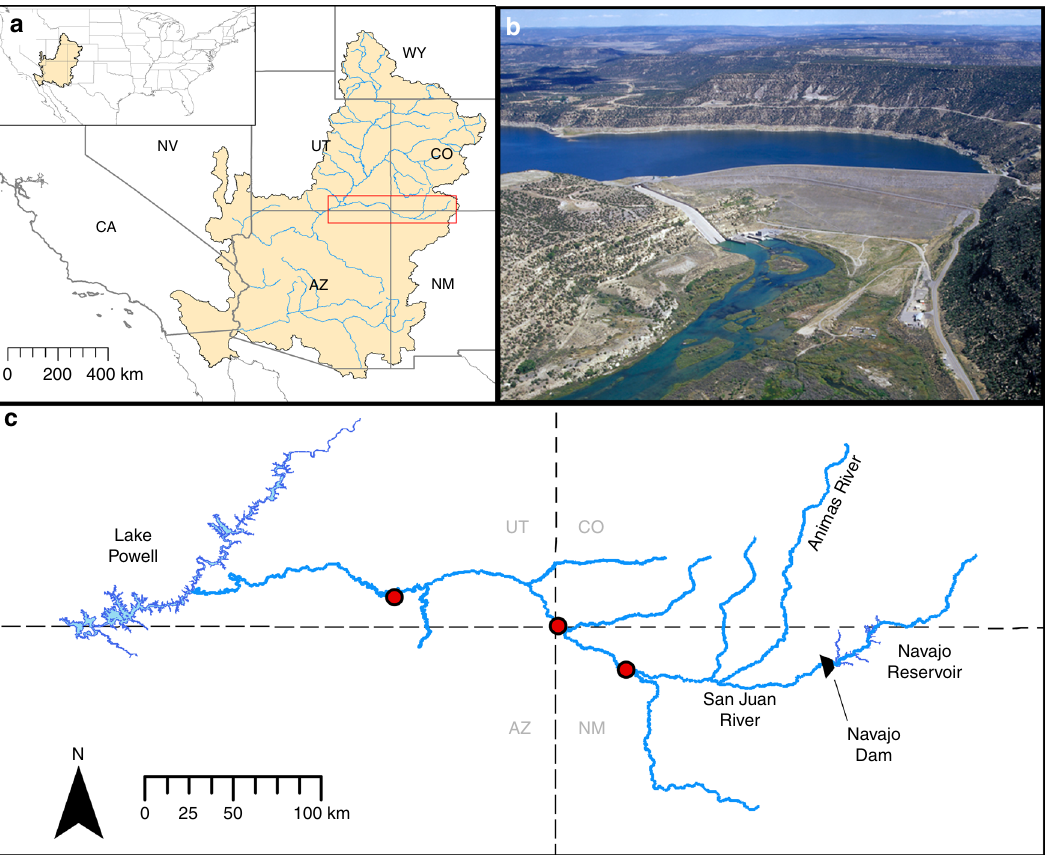
Fig. 1 Map of study region. a The San Juan River Basin (red box) is a major tributary of the Colorado River Basin, located in southwestern United States. b The Navajo Dam (height, 123 m) is an earthen dam on the San Juan River that creates the Navajo Reservoir. c Our case study focused on the region from Navajo Reservoir (river kilometer 360) to Lake Powell (river kilometer 0). Red circles indicate the USGS fl ow gage stations used in the study. Photo